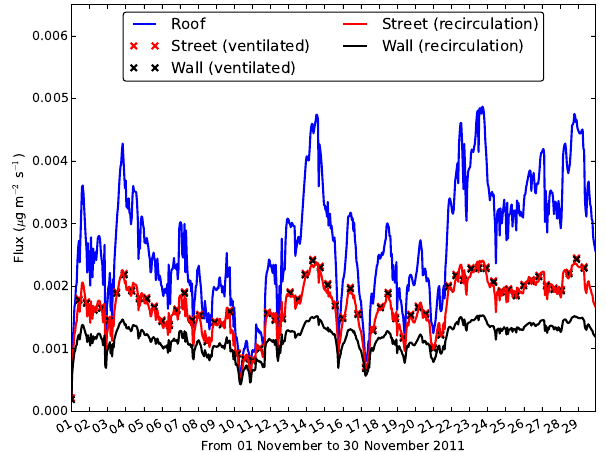
Figure 13. Time series of flux (µgm − 2 s − 1 ) of pollutants ( c = 1µgm − 3 ) for each surface and region in one chosen urban grid cell in November 2011.